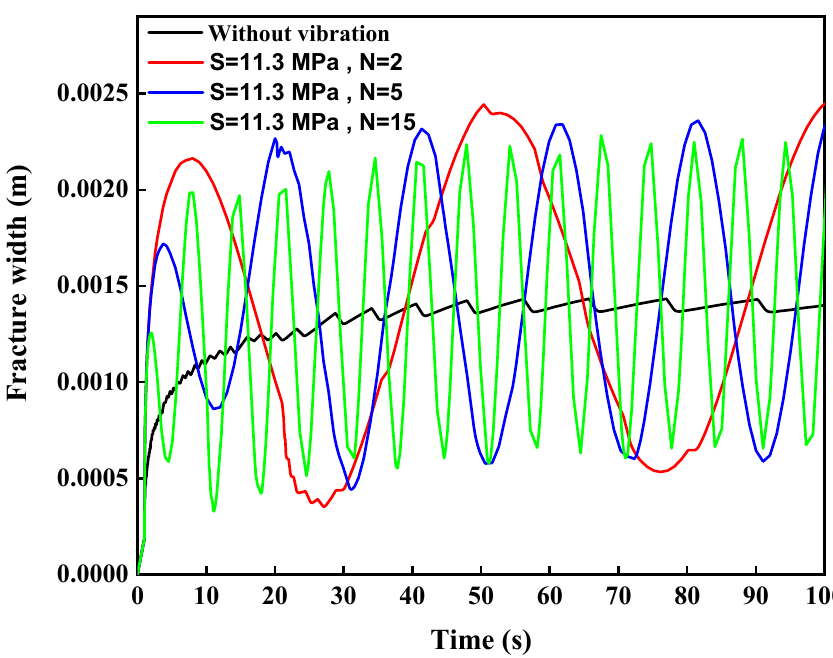
Figure 9. Fracture width evolution in function of the time for constant cyclic load magnitude and different number of cyclic loads.